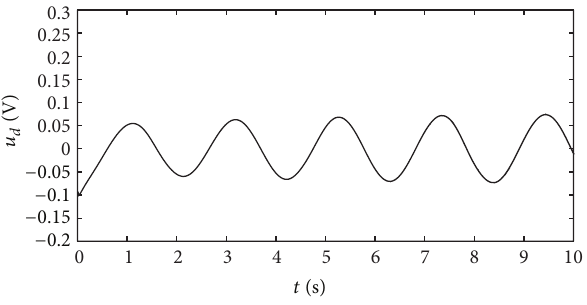
Figure 9: 𝑑 -axis voltage of control input. Figure 7: The rotor position tracking error. Figure 10, it is seen clearly that all state variables are bounded and convergent. Meanwhile, by contrast with Figure 3, the shown in Figures 8 and 9. Moreover, the robustness of the proposed controller can suppress the chaos of PMSM. There- proposed controllers against uncertainty in system parame- fore, these simulation results demonstrate the effectiveness of ters and disturbance is analyzed by simulation. According to the proposed control in achieving its